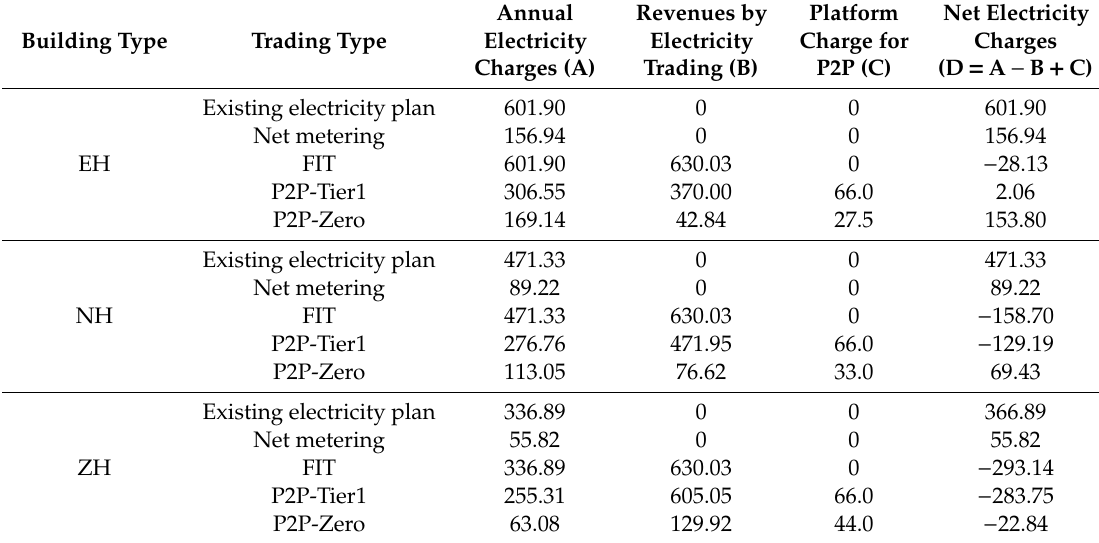
Table 15. Annual net electricity charges by trading types (unit: